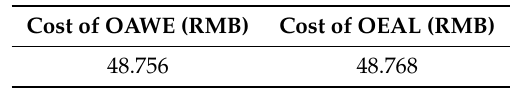
Table 5. Comparison of the cost between OEAL and OACI.